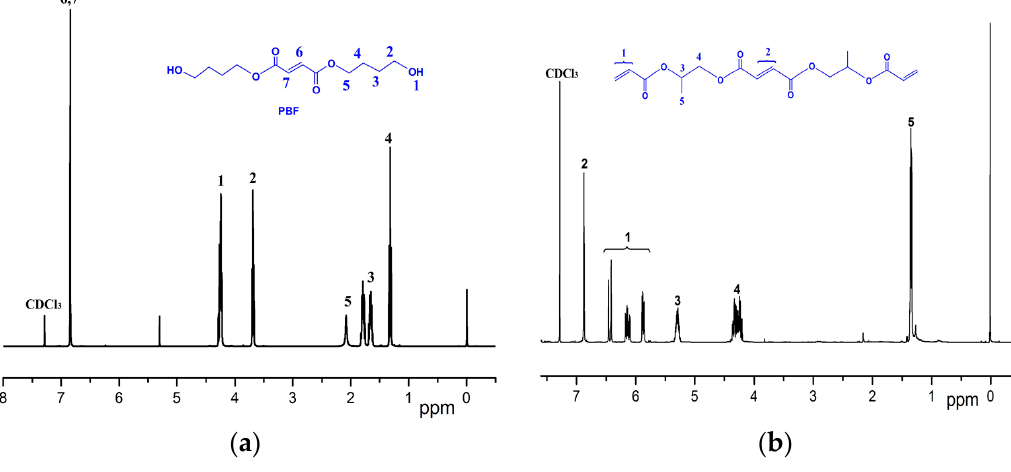
Figure 2. 1 H NMR spectrum of PBF ( a ) and PPF-DA ( b ).